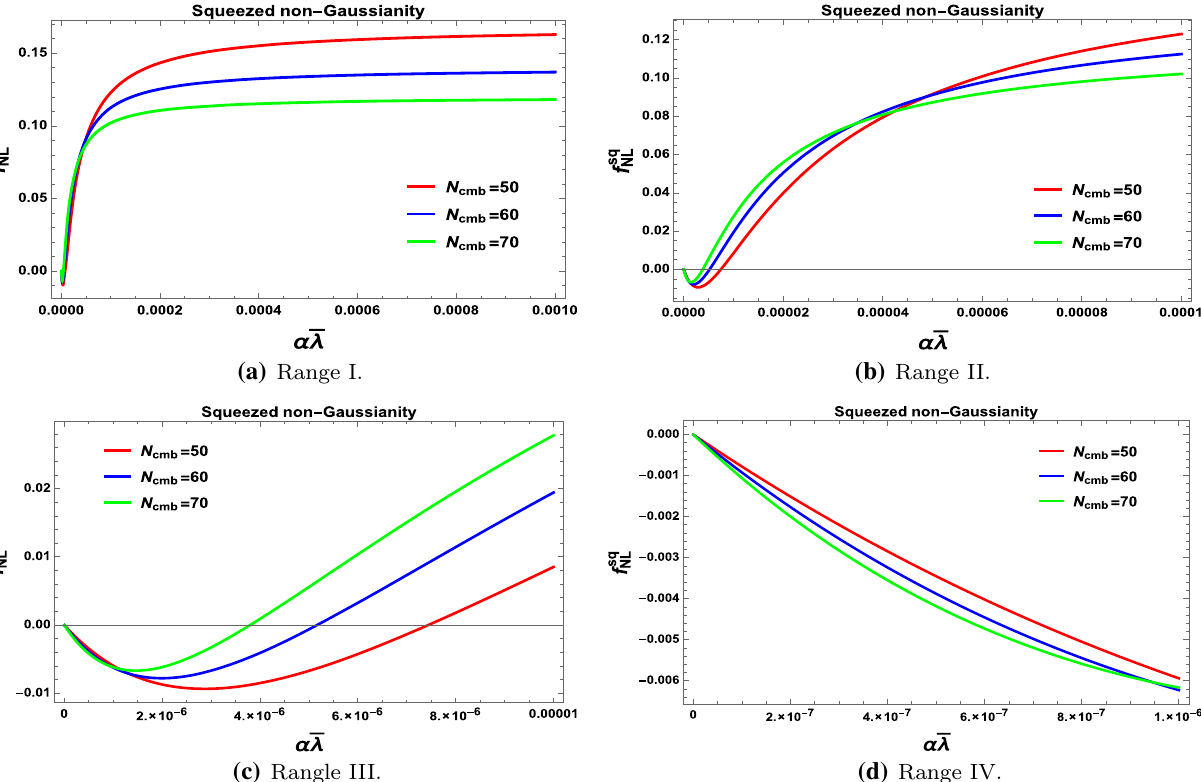
Fig. 14 Representative diagram for squeezed non-Gaussian three point amplitude vs. product of the parameters α ¯ λ in four different regions for = 50 ( red ), N = 60 ( blue ) and N = 70 ( green N cmb cmb cmb